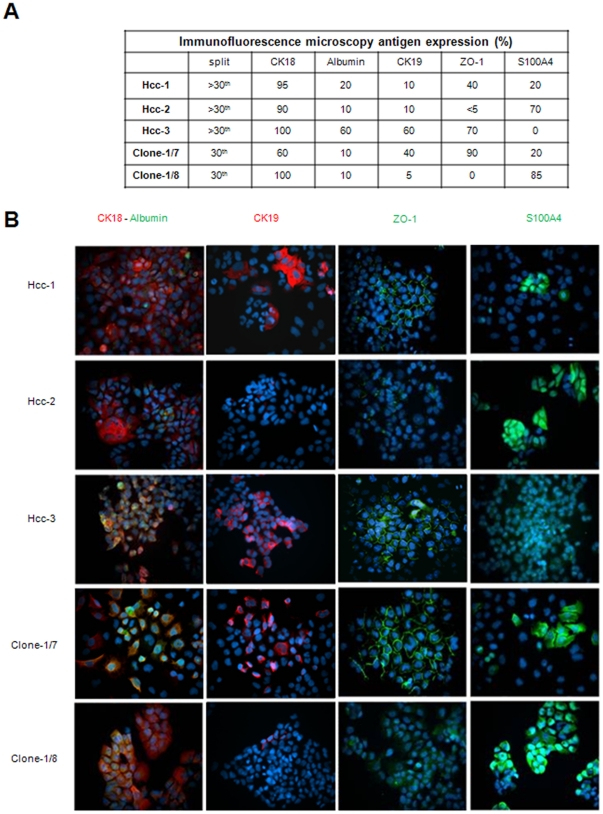
Immunofluorescence of cell culture.A) Double and single immunofluorescence staining of hcc-1, hcc-2, hcc-3, clone-1/7 and clone-1/8 using anti-CK18, -albumin, -CK19,-S100A4 and -ZO-1 antibodies. All nuclei were stained with DAPI (blue); original magnification 40×. B) Percentage of antigen expression in the three cell populations and clones.